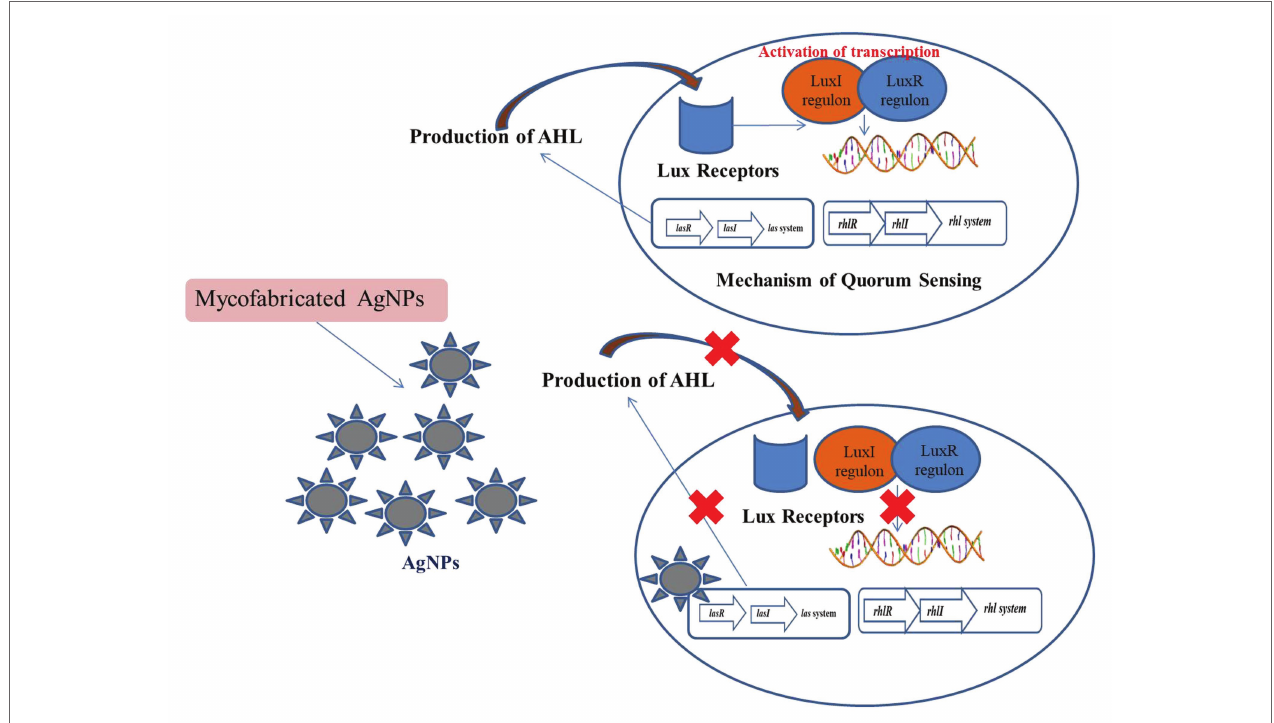
FIGURE 4 | Mechanism of inhibition of QS by myco-fabricated Ag